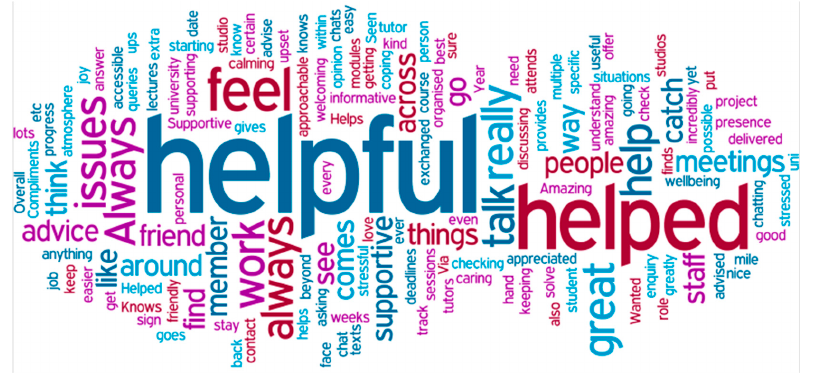
Figure 2. Visual frequency display of student survey data.